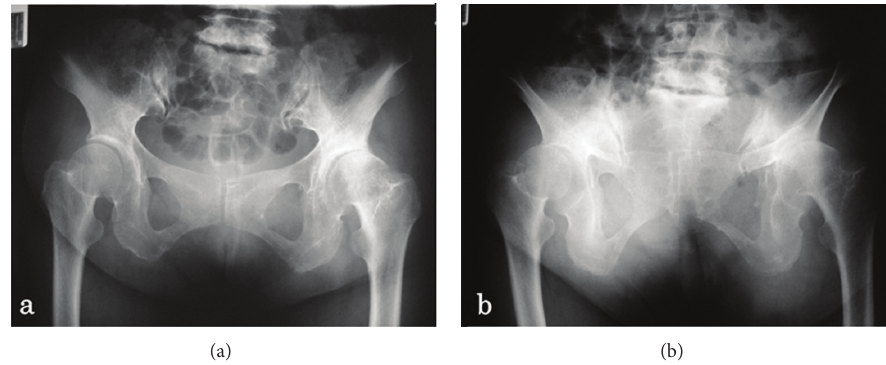
Figure 1: Anteroposterior radiographs of the bilateral hip joints on lying (a) and standing (b). Plain radiography showed osteoarthritic changes of hip joints and severe posterior pelvic tilt on visualizing superior displacement of both femoral heads.